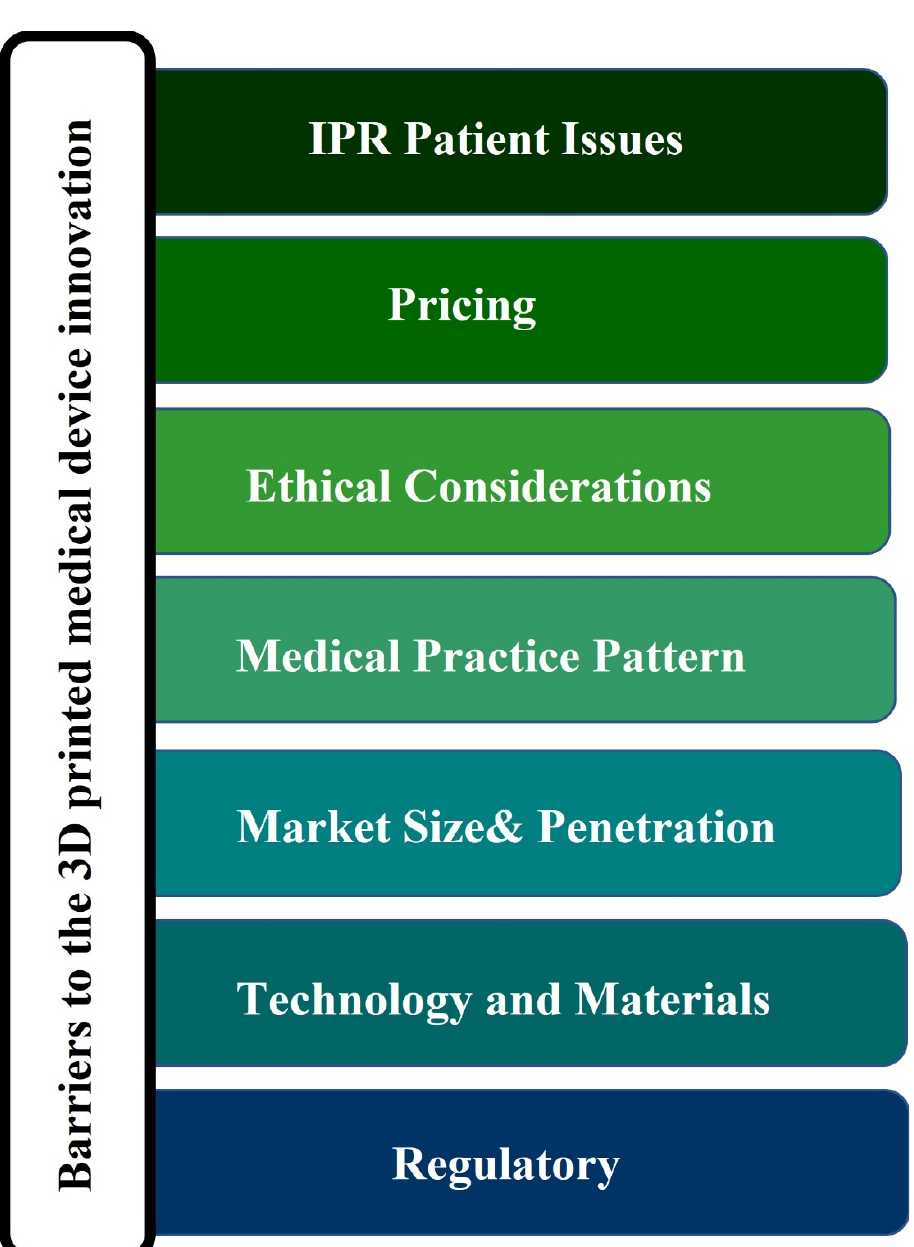
Figure 4. Barriers to the innovation of 3D printed medical devices. Abbreviations: IPR: intellectual property rights.